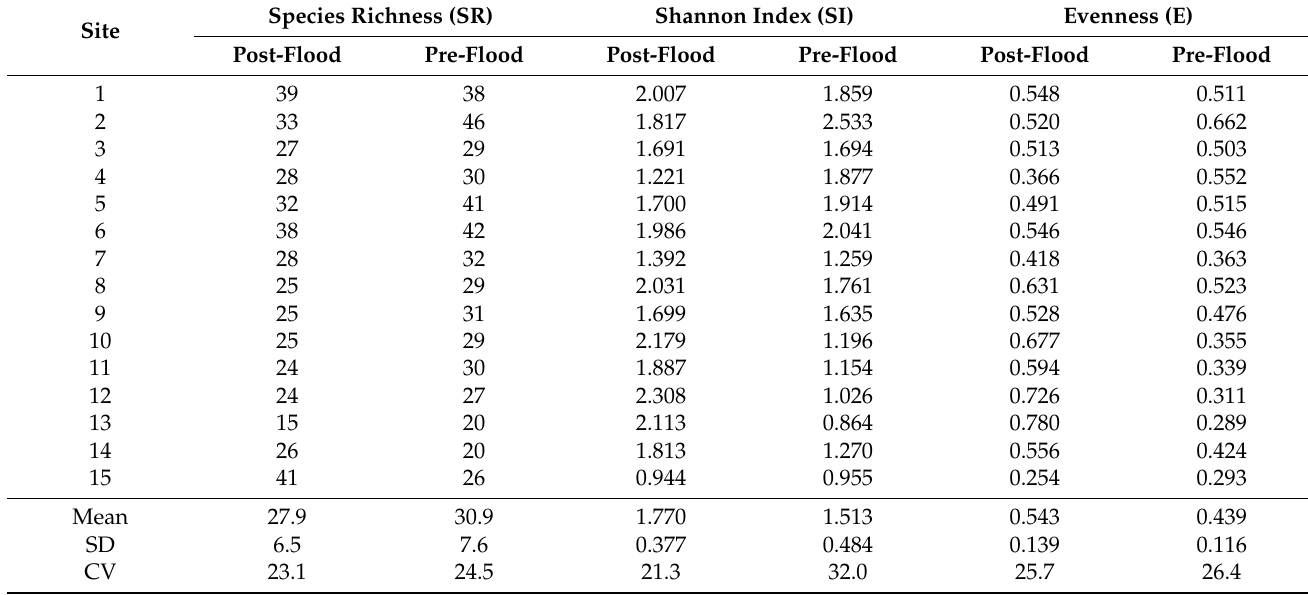
Table 5. Species richness and biodiversity of phytoplankton in Lake Nasser in the post-flood and pre-flood periods.